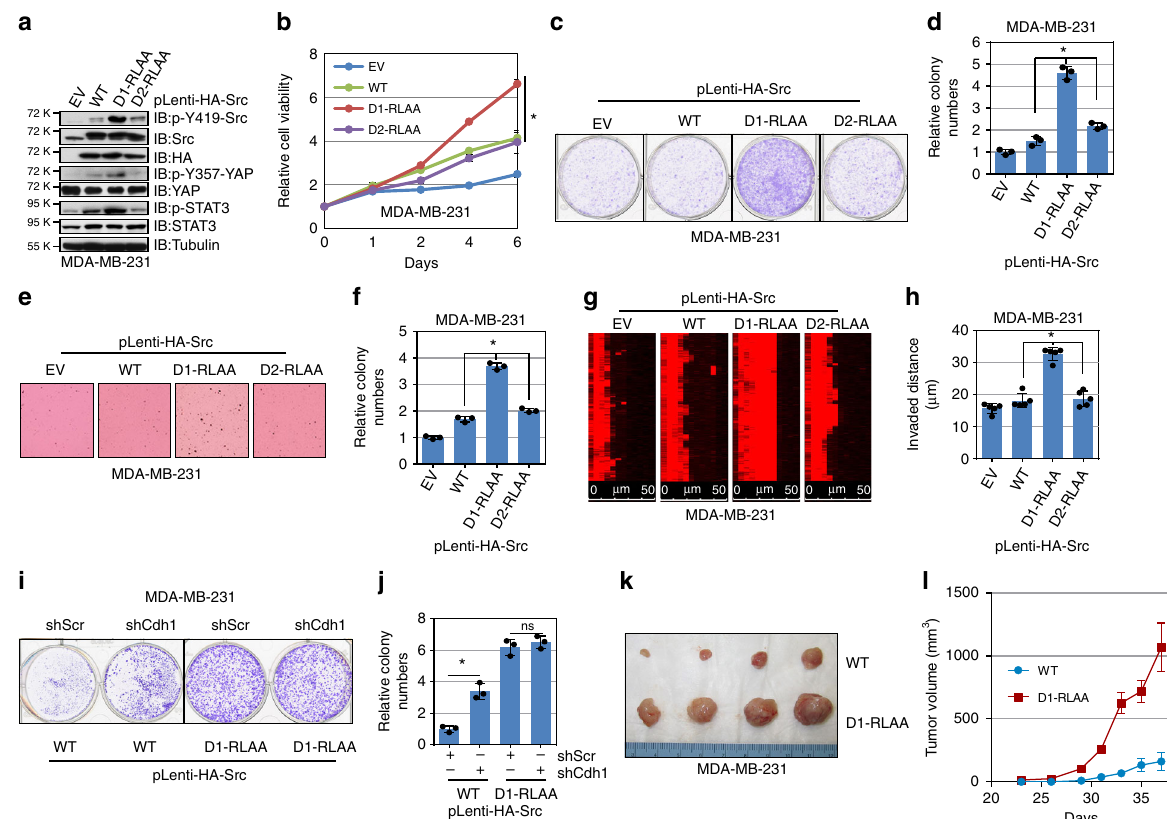
Fig. 5 Cdh1-binding de fi cient Src mutant promotes breast cancer cell growth. a Immunoblot (IB) analysis of whole-cell lysates (WCL) derived from MDA- MB-231 cells stably expressing empty vector (EV), WT-Src, D-box-1-mutated, or D-box-2-mutated Src. b MDA-MB-231 cells generated in ( c ) were subjected to cell proliferation assays in DMEM medium supplemented with 10% FBS for 6 days. Cell viability was determined at the indicated time points. The relative cell viability was calculated as mean ± SD ( n = 3). * P < 0.05; Student ’ s t test. c , d MDA-MB-231 cells generated in ( a ) were seeded for clonogenic survival assays (1000 cells per well). Fourteen days after plating, crystal violet was used to stain the formed colonies ( c ) and the relative colony numbers were counted as mean ± SD ( n = 3), * P < 0.05; Student ’ s t test ( d ). e , f MDA-MB-231 cells generated in ( a ) were subjected to soft agar